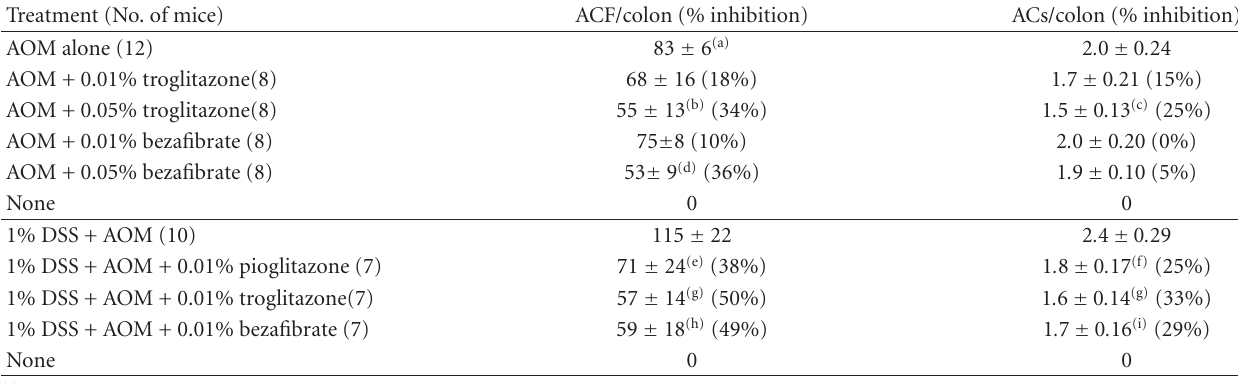
Table 1: E ff ects of PPAR ligands on ACF formation in rats.